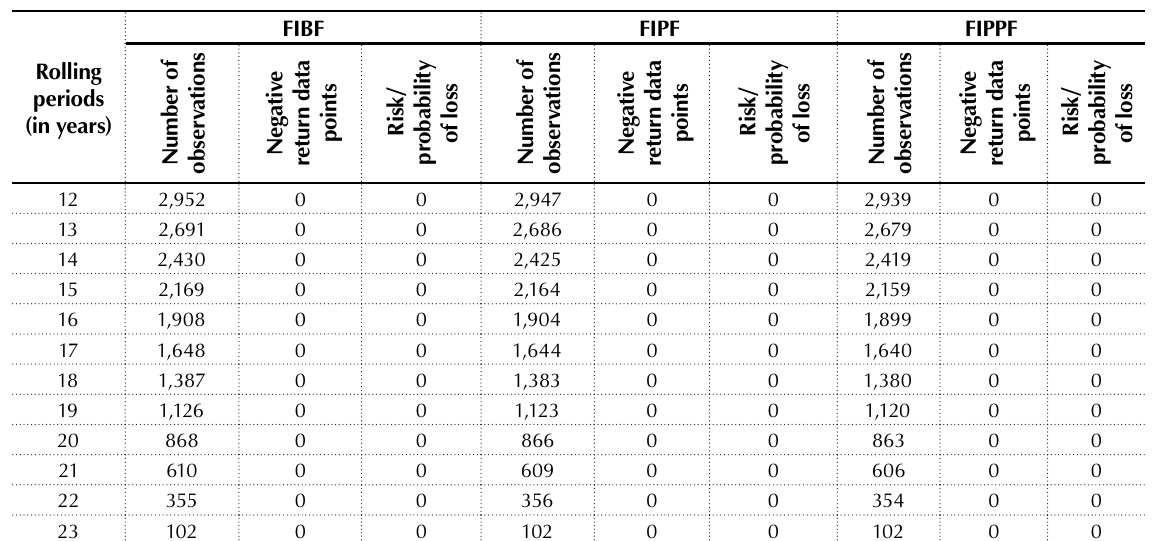
Table 12 (cont.). Rolling period risk and return behavior of FIBF, FIPF and FIPPF